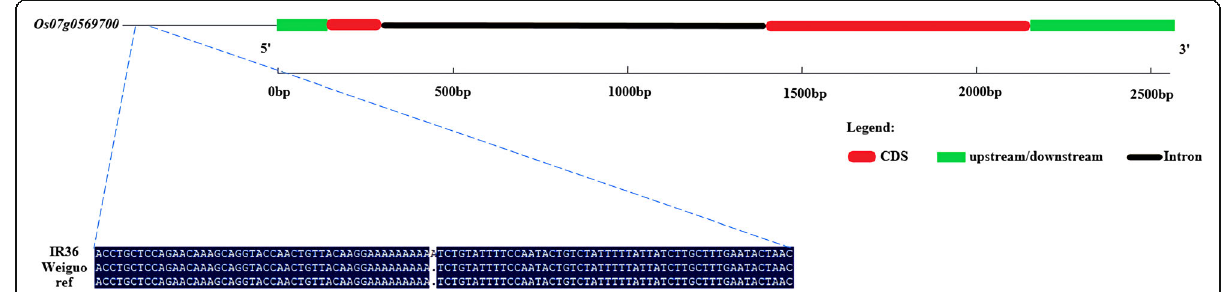
Fig. 9 Sequence difference analysis of Os07g0569700 . The gene structure of Os07g0569700 and sequence differences in Os07g0569700 between IR36 and Weiguo. Ref is the reference sequence of Nipponbare